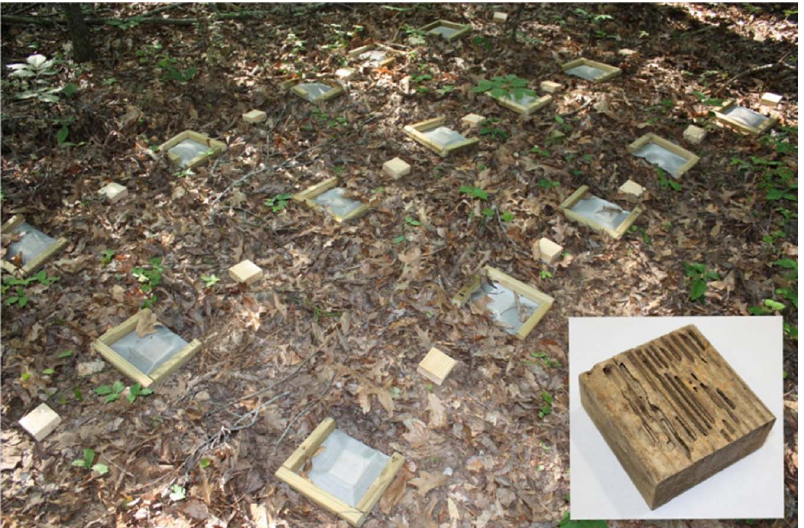
Figure 3. Protected and unprotected blocks without termite damage were used to determine how the mesh bags affected water content beyond the exclusion of insects. An unprotected block with Reticulitermes damage is shown in the inset.